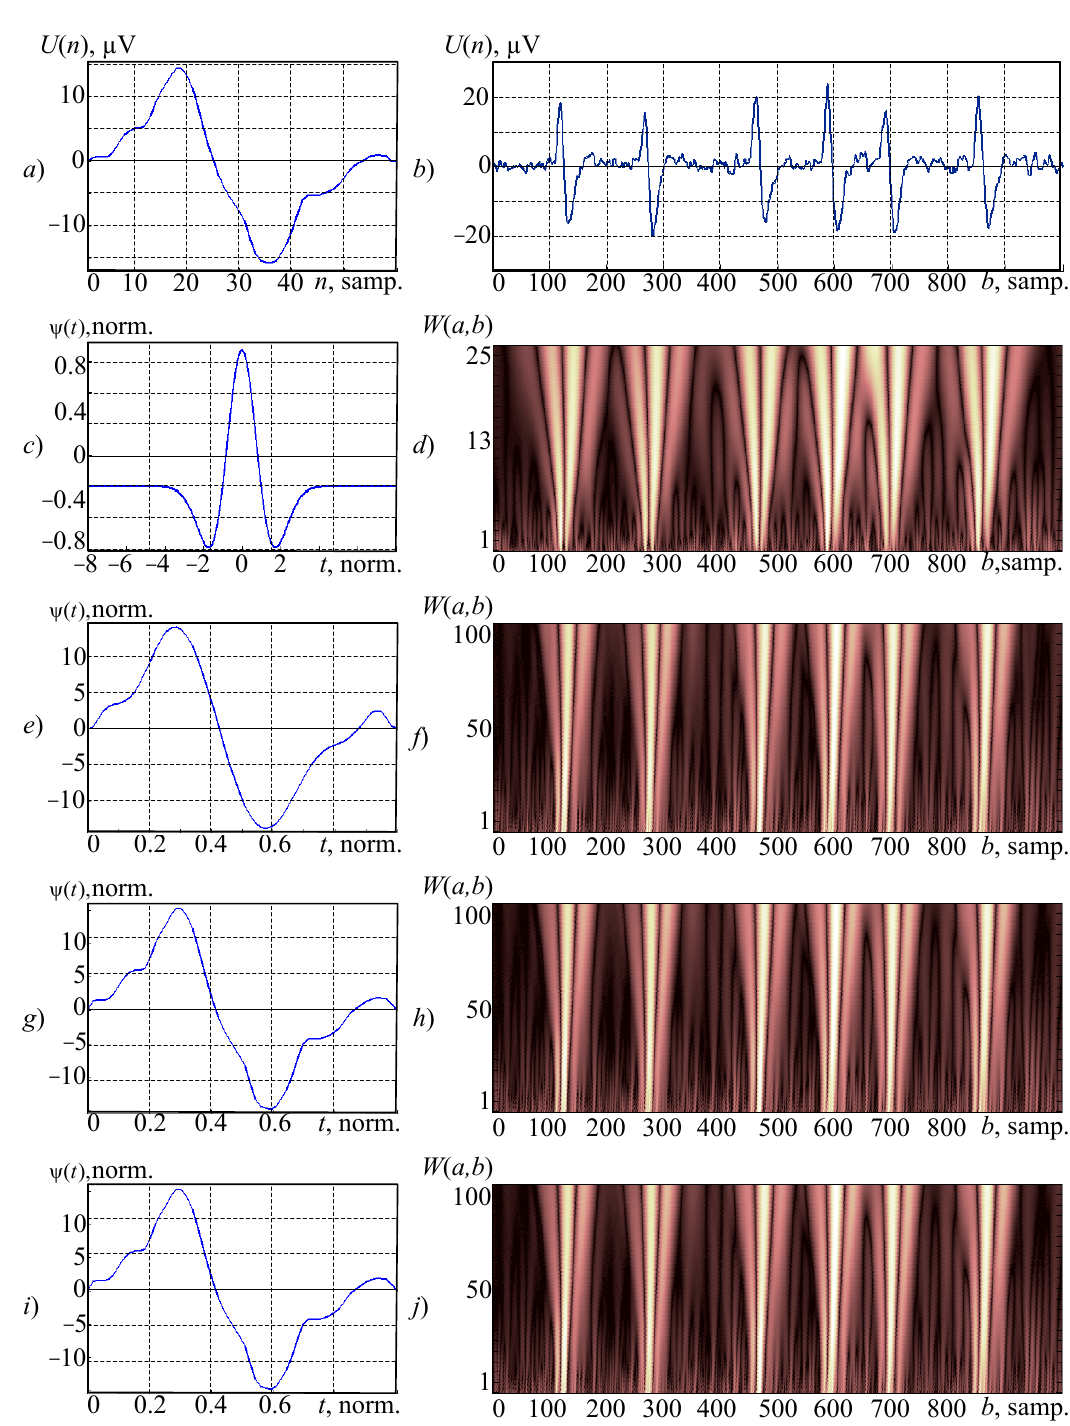
Figure 2. Results of research on synthesized wavelets: ( a ) the sample; ( b ) the analyzed signal; ( c ) the “Mexican hat” wavelet; the wavelet-spectrogram ( d ) that was obtained with its application; ( e , g , i ) the wavelets, obtained on the basis of polynomial, neural network, and spline models, respectively (before normalization); ( f , h , j ) wavelet-spectrograms obtained using synthesized wavelets ( e , g , i ),